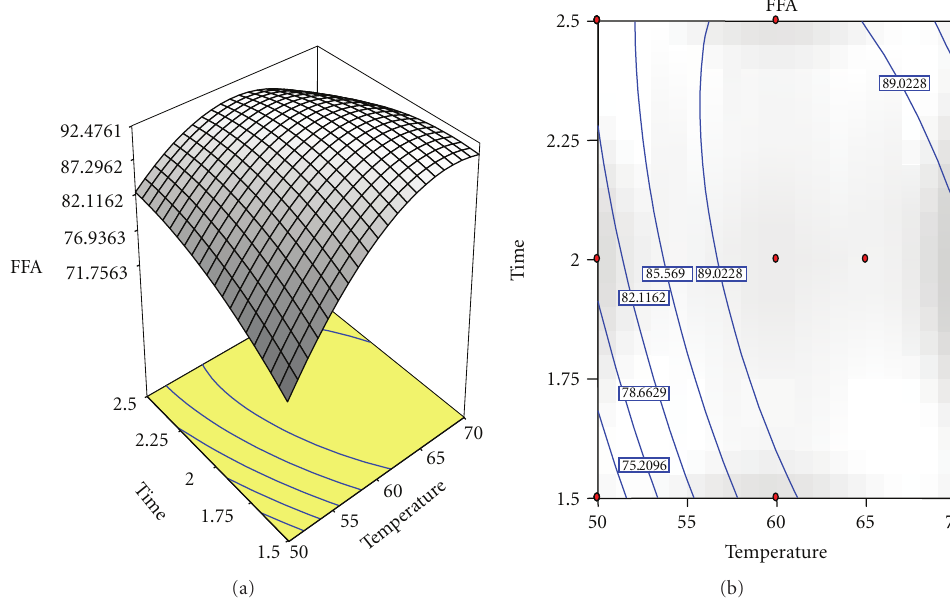
Figure 3: Response surface (a) and contour plots (b) for the e ff ect of the reaction temperature ( X 2 , ◦ C) and reaction time ( X 3 , h) on the FFA%.